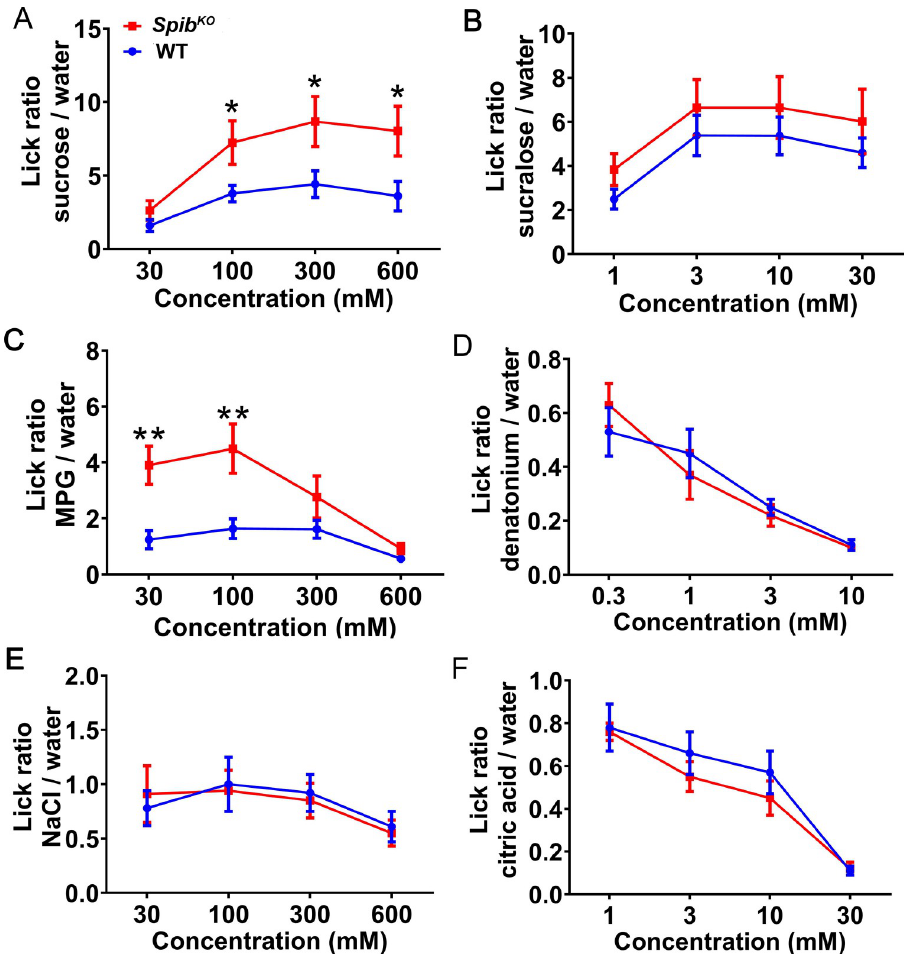
Fig 4. Spib KO mice show increased behavioral attraction to sweet and umami tastants. Brief access tests were used to measure behavioral responses to sweet (sucrose and sucralose, A and B ), umami (monopotassium glutamate [MPG], C ), bitter (denatonium, D ), salty (NaCl, E ), and sour (citric acid, F ) taste stimuli. (The data underlying the graphs can be found in Data A-F in S8_Data.) Compared to littermate control WT mice, Spib KO mice show increased lick responses to sweet and umami (sucrose and MPG), while the responses to other taste stimuli are unchanged. Lick ratios were calculated by dividing the number of licks to a taste solution by the number of licks to water in each test session. Data are means ± SEM analyzed with two-way ANOVA with post hoc t test. N = 12 (WT mice) and 14 ( Spib KO mice). � p < .05, �� p <